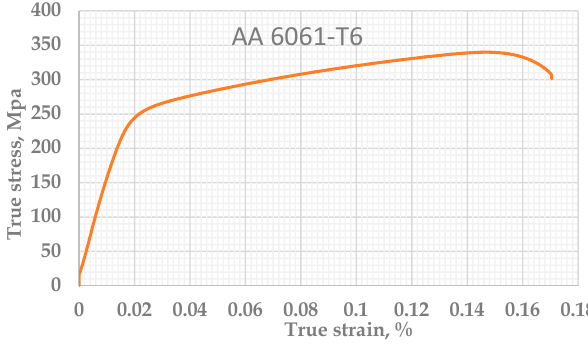
Figure 3. True stress-strain curve of AA6061-T6.